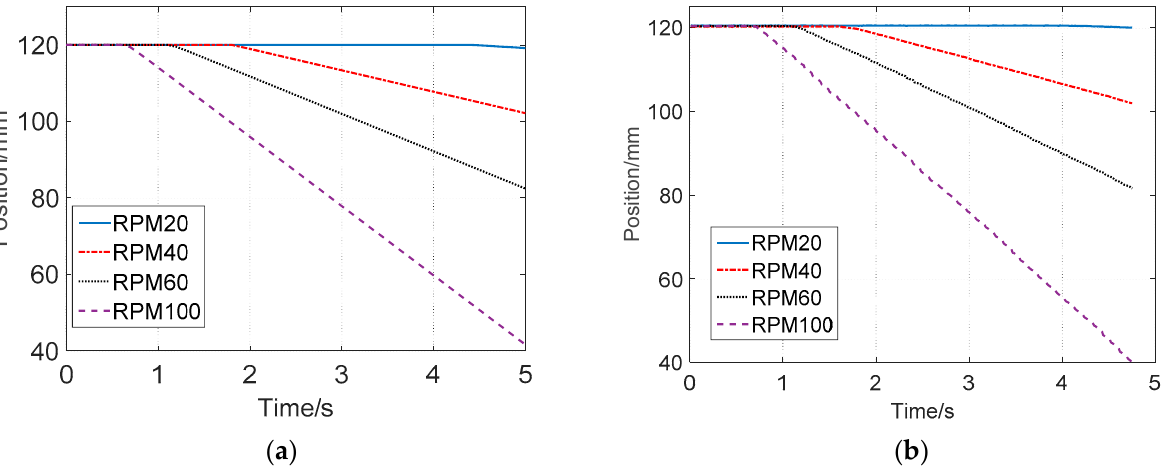
Figure 23. The simulation and the experimental results of the position output in the open-loop control at the pump speeds of 20, 40, 60, and 100 RPM. ( a ) the simulation results. ( b ) the experimental results. It can be seen from Figure 23 that when the pump speed was low to 20 RPM, the position started to change at 4.2 s. When the pump speed was 40 RPM, 60 RPM, or 100 RPM, the position started to change at 1.7 s, 1.2 s, and 0.7 s, respectively. The larger the flow rate,